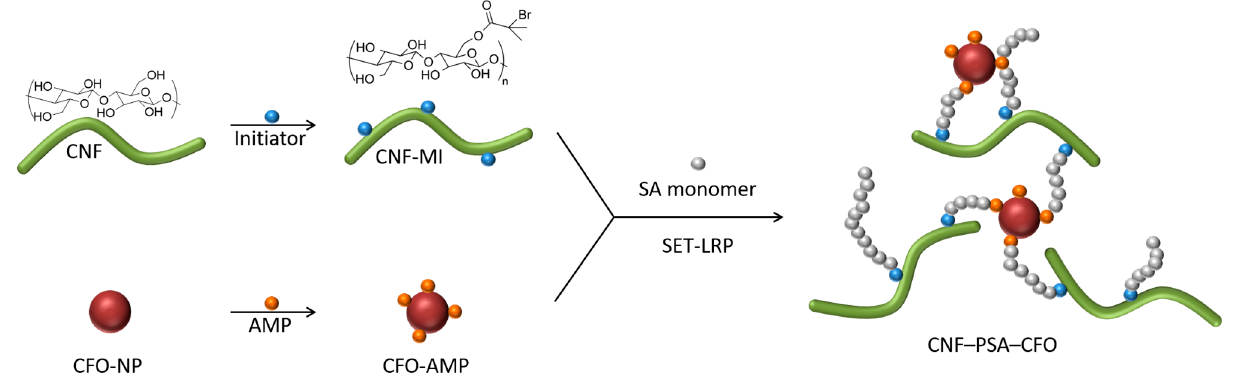
Figure 1. Schematic modification strategy of CNF with PSA and CFO nanoparticles. The mechanical disintegration of wood pulp with a high ‐ pressure microfluidizer re ‐ sulted in a 2.1 wt% CNF aqueous gel. On the surface of the CNF, an excessive number of